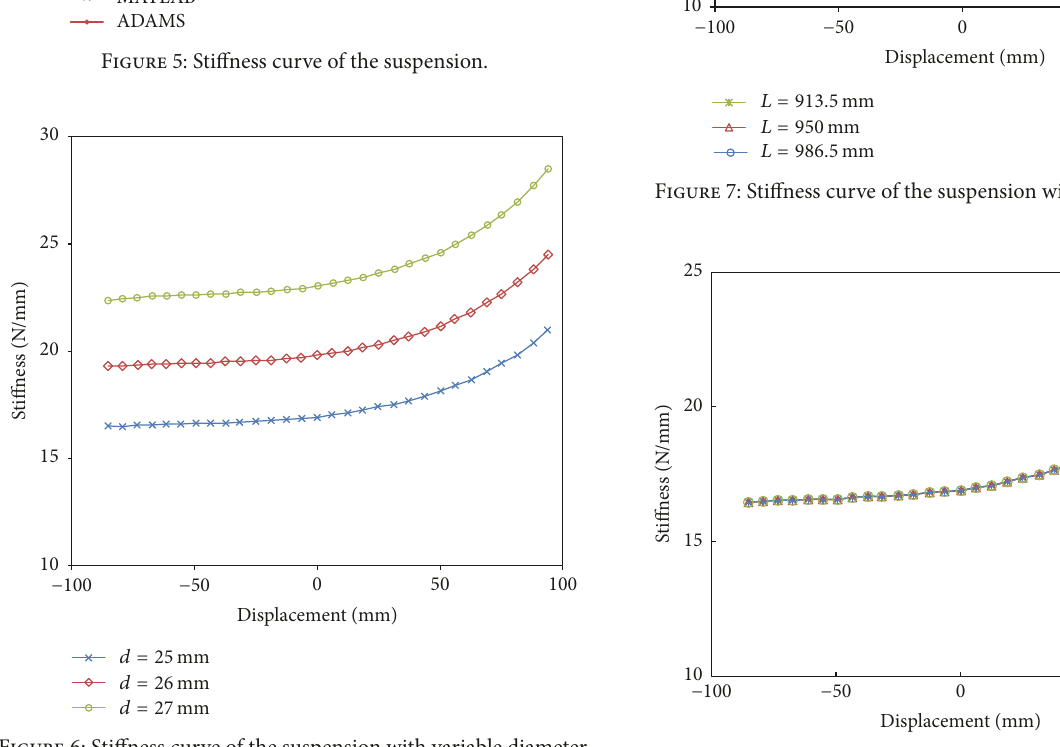
Figure 6: Stiffness curve of the suspension with variable diameter.